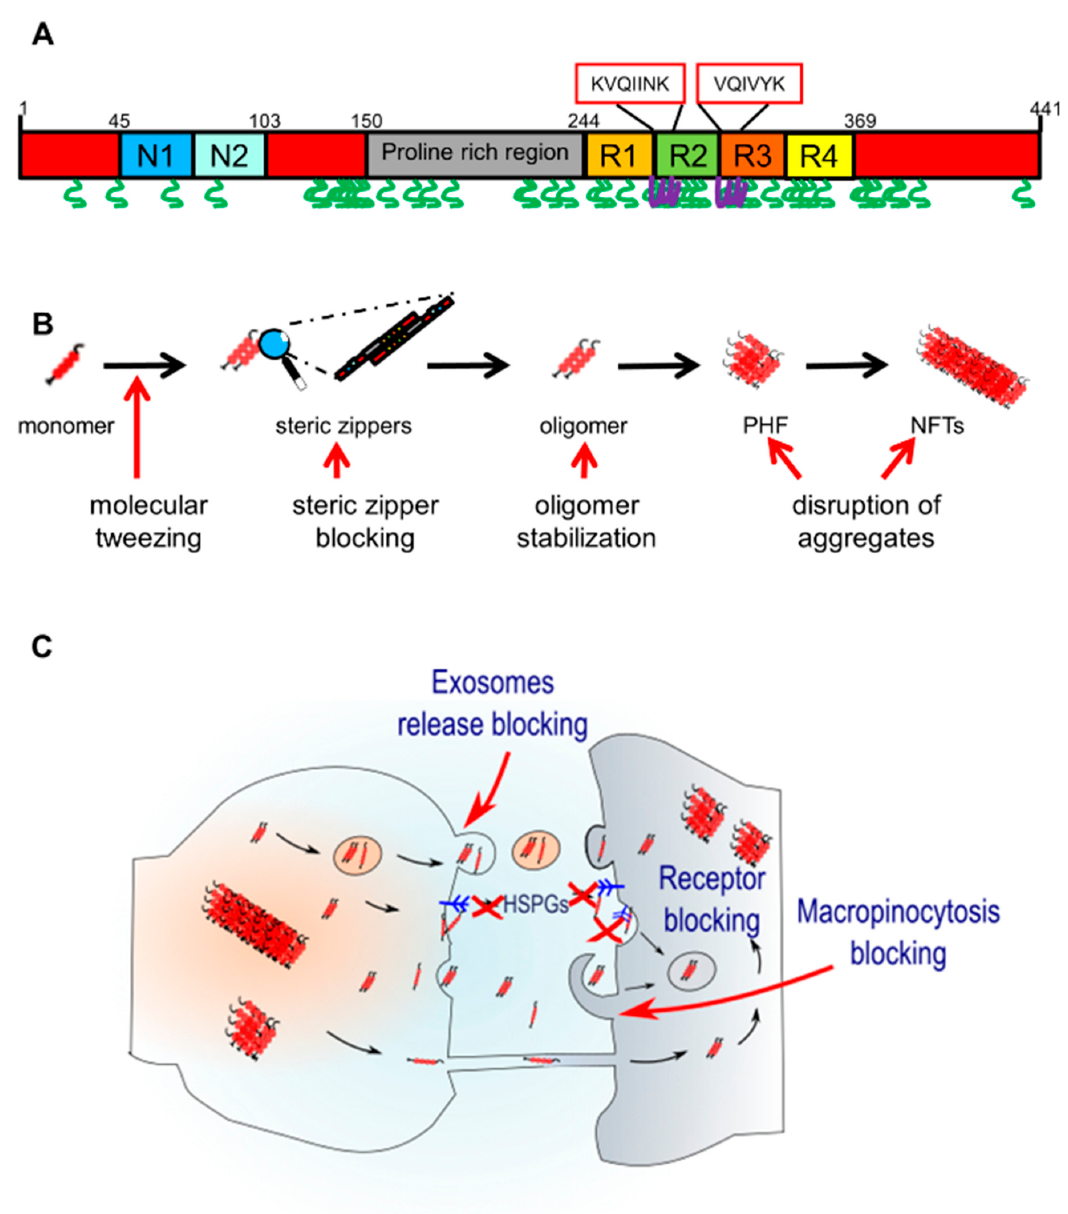
Figure 2. Inhibition of tau aggregation and spreading. ( A ) Sites for direct binding of covalent tau aggregation inhibitors. There are two main groups that bind to the VQIINK and VQIVYK sequences (purple) or to the K residues (green). ( B ) Mechanisms of action of non-covalent tau aggregation inhibitors on tau aggregation. The red arrows point to the different points of inhibition. Molecular tweezers lower aggregation propensity by increasing reconfiguration rate, steric zipper blockers block the formation of the steric zippers structures, and oligomerization stabilizers block the process in the oligomer phase. Finally, PHFs and NFTs can be broken by aggregation disruptors. ( C ) Tau spreading can be inhibited by blocking exosomal release, by blocking tau interaction with HSPG, or by blocking endocytosis, either by blocking the receptors responsible for tau internalization or by blocking